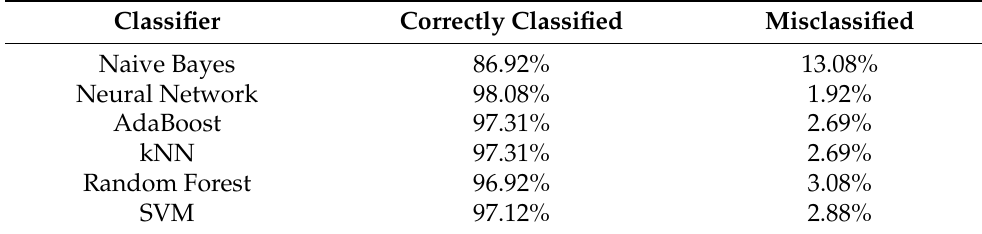
Table 9. Results of Classification Algorithms.